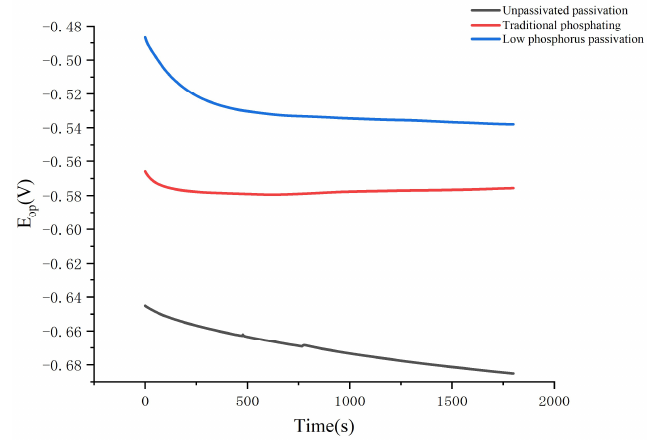
Figure 1. Open circuit potential of the three samples in a 3.5% NaCl